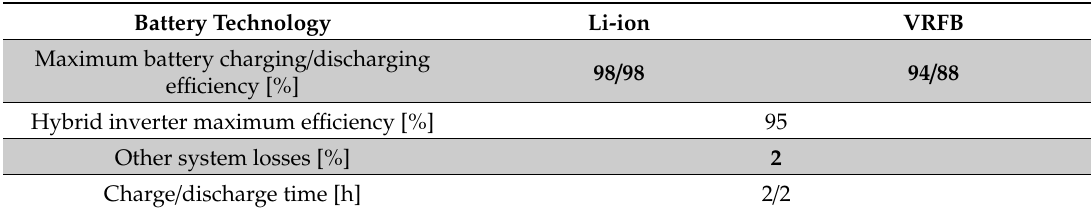
Table 3. Main technical–economic parameters for simulations using di ff erent battery